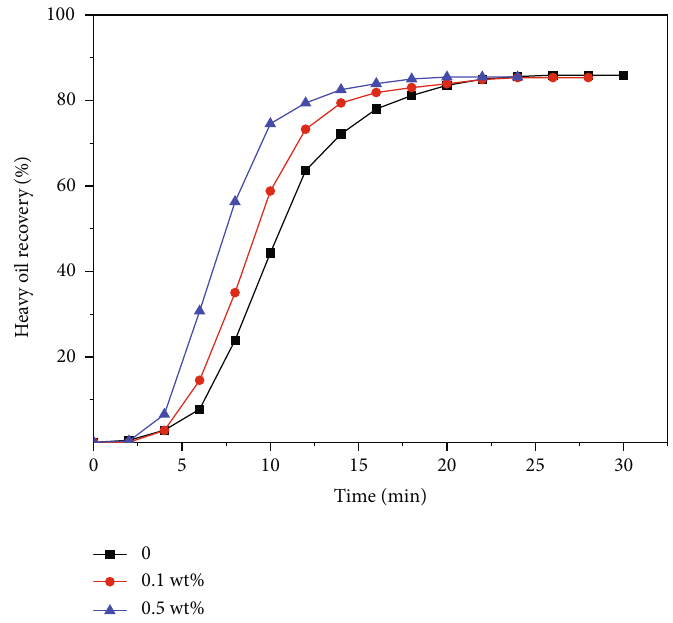
Figure 14: The experimental heavy oil recovery curves of each group under di ff erent mass fractions of nanoparticles.